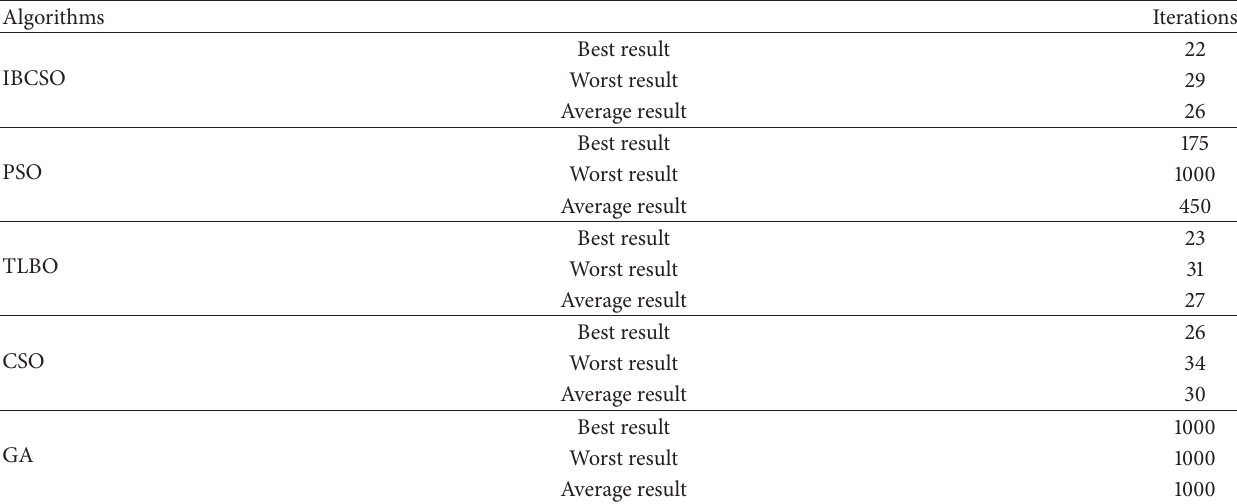
Table 5: Iterations required by IBCSO, CSO, PSO, GA, and